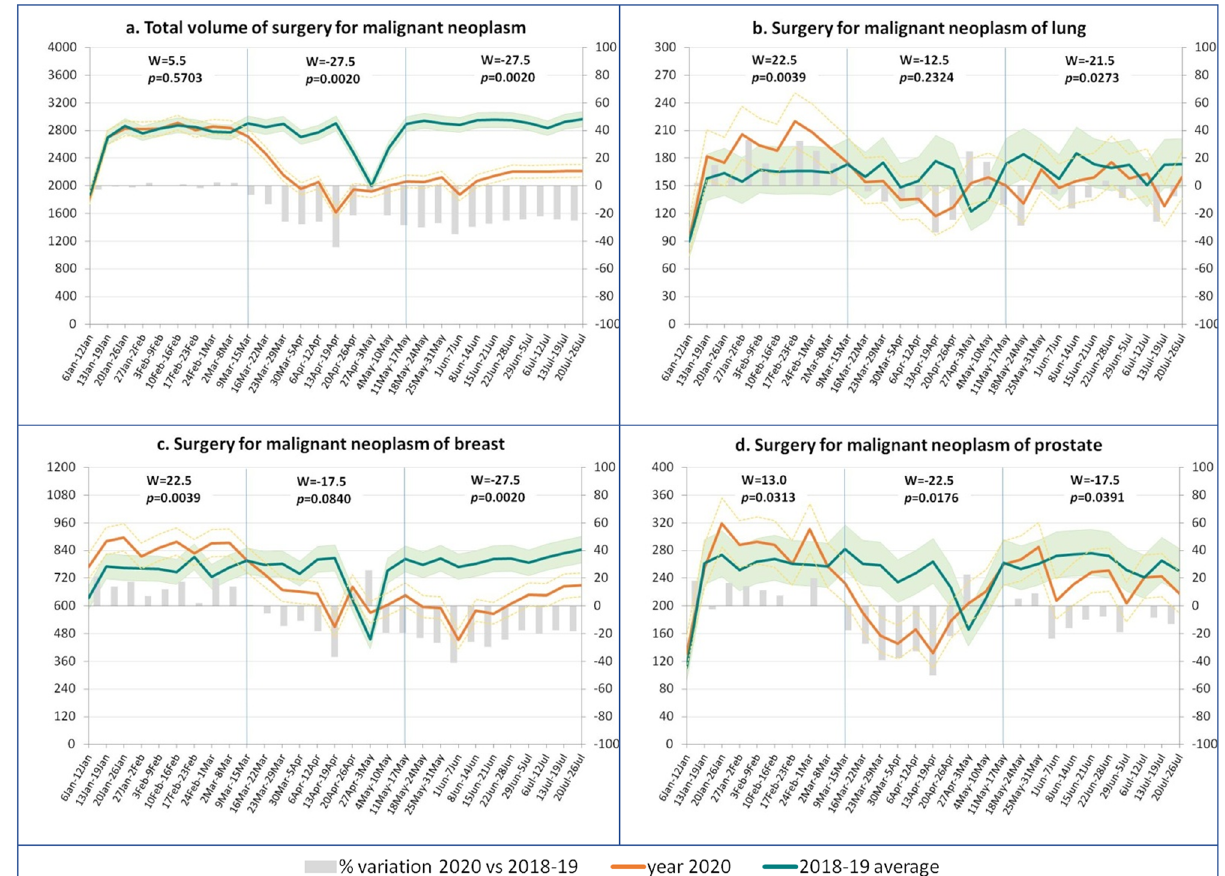
Figure 2. Impact of Covid-19 on oncological hospital care in Italy: surgery volumes by sub-period*. Weekly trend of indicators (left axis) with 95% CI and % variations (right axis)—January–July 2020 versus